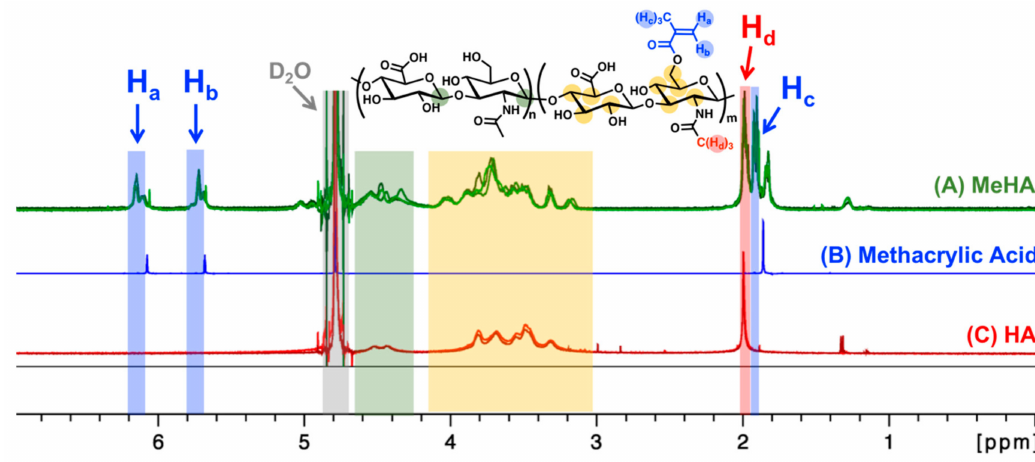
Figure 1. 1 H-NMR spectra of methacrylated hyaluronic acid (A, MeHA; three samples; green lines), methacrylic acid (B, blue line), and unmodified hyaluronic acid (C, HA; two samples; red lines). Methacrylate peaks (blue arrows; δ 6.2 ppm, δ 5.8 ppm, δ 1.9 ppm; H a , H b , H c ) were used to calculate δ 2.0–2.1 ppm (red arrow; H d ). D 2 O solvent peak was set to 4.79 ppm (gray area) [27]. The color-coded